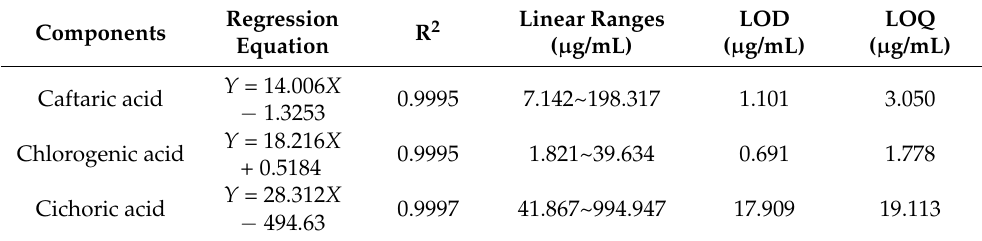
Table 1. Regression equation, correlation coefficient (R 2 ), linear ranges, limit of quantitation (LOQ) and detection (LOD) of three phenolic acids.